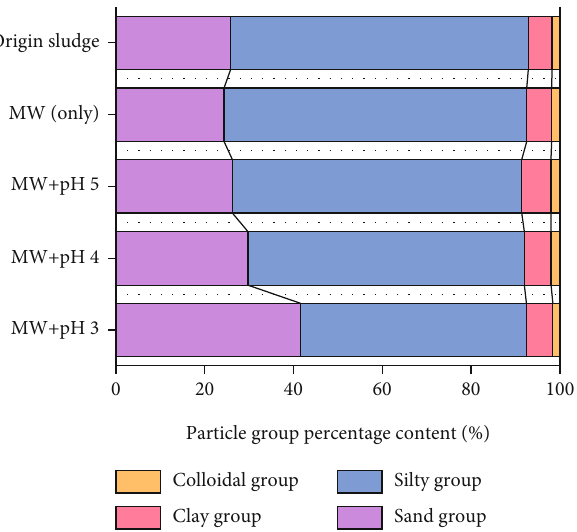
Figure 6: Percentage content of particle groups in sludge treated by